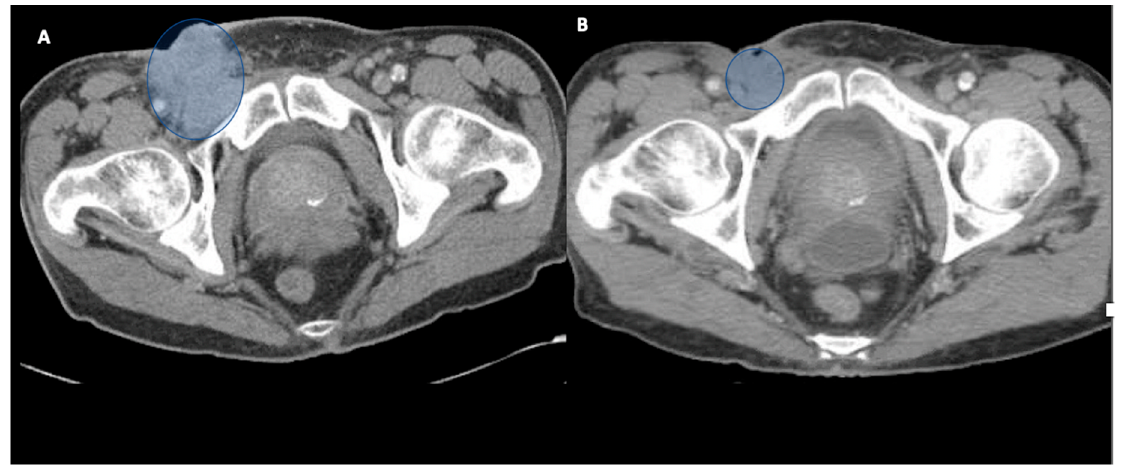
Figure 2. Computerized tomography ( CT) scan images from baseline ( A ) and post treatment ( B ). Time points represent significant decrease in size of necrotic right inguinal nodal mass infiltrating the muscle, originally 5.3 × 5.0 cm prior to radiation therapy (RT).